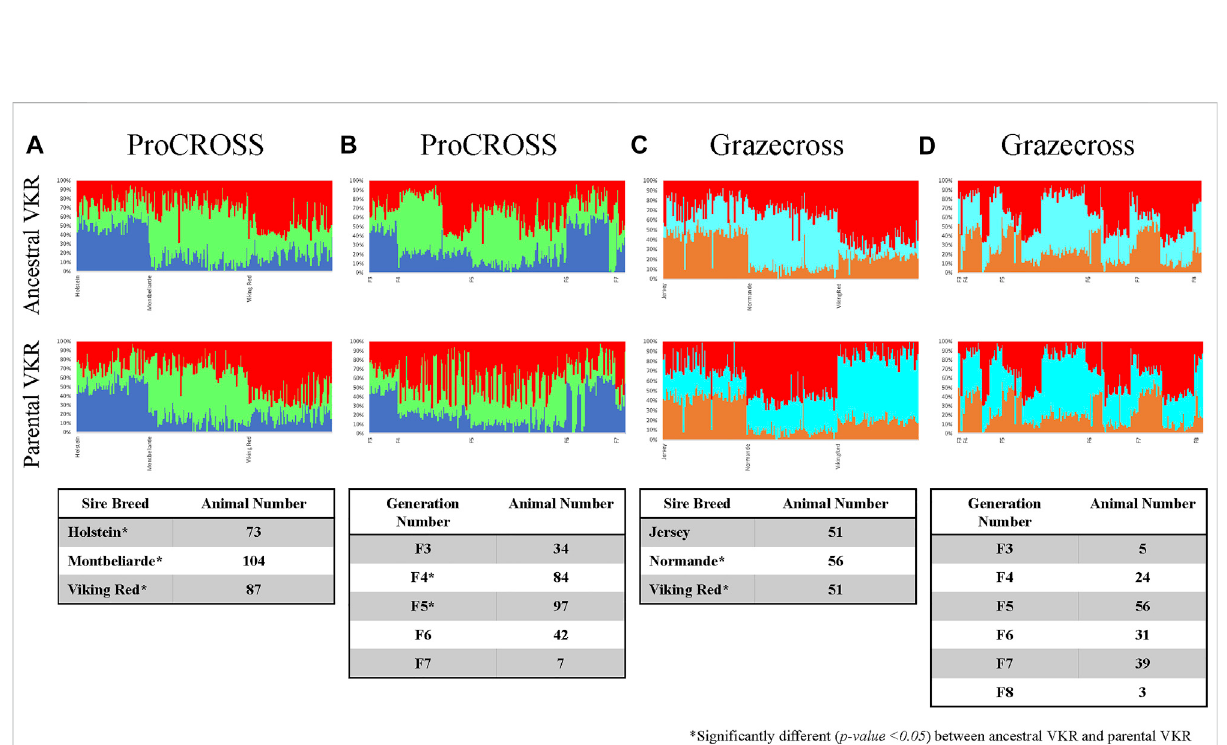
FIGURE 4 Admixture analysis forProCROSS andGrazecrossindividualsusingall majorparentalpopulationsat K =3.Thetoprowused ancestralVKR (FAY, DNR,andSWR)asthereferencepopulationwhereasthebottomrowusedparentalVKRasthereferencepopulation.Columns (A,C) orderedadmixed individuals across the X -axis based on their recent sire while columns (B,D) ordered animals based on the generation of birth to better view the impact of these variables on the admixed populations. Tables within each column describe the distribution of admixed individuals based on assigned